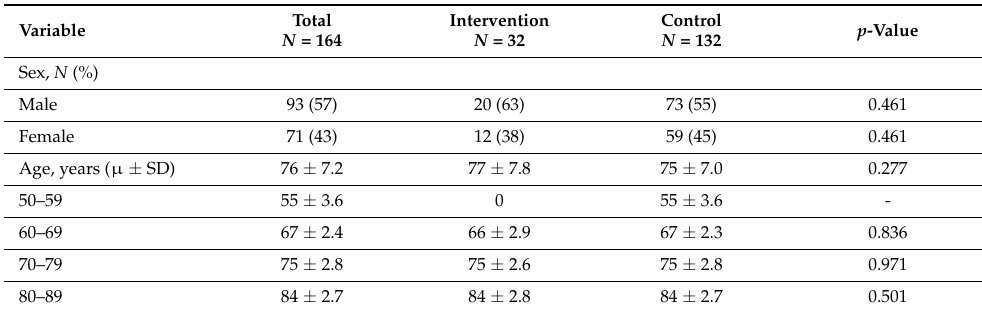
Table 2. Patient